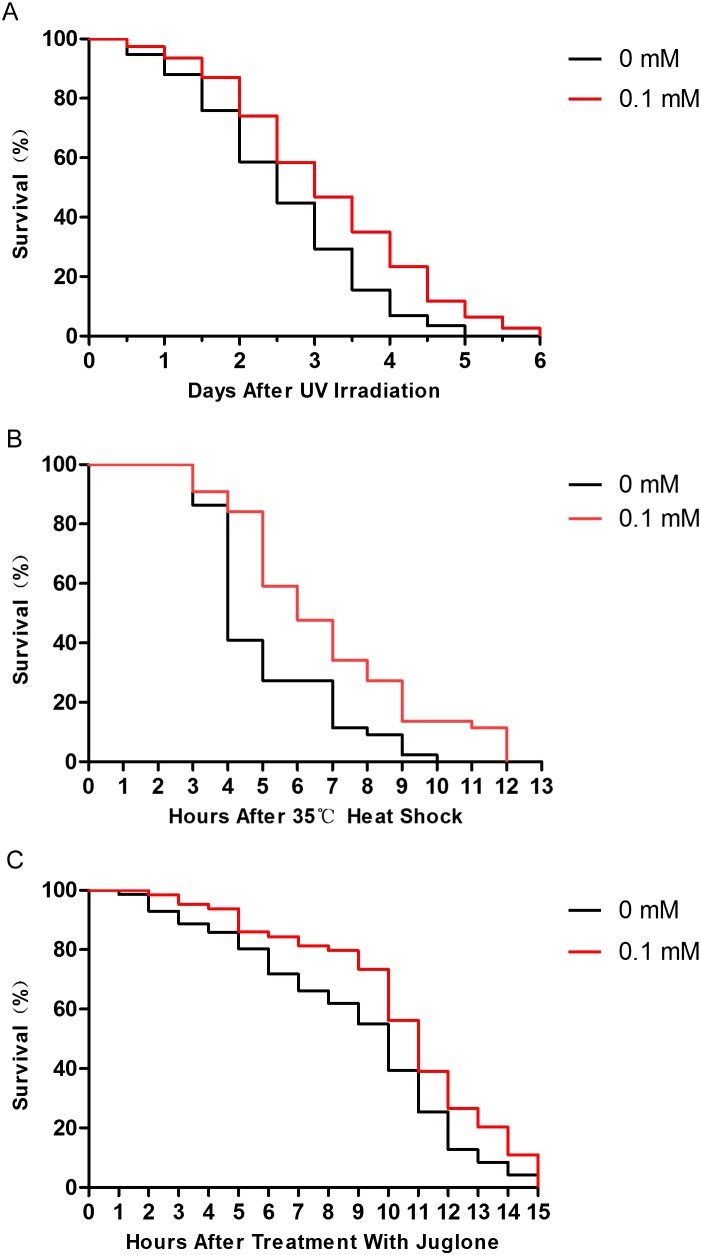
Didymin improved the survival of wild-type C. elegans nematodes exposed to various stressors.The adult nematodes were treated with 0.1 mM didymin or DMSO (vehicle control) for 48 h, followed by three types of stressors. Compared to control nematodes, didymin significantly raised the resistance of nematodes to (A) UV irradiation (n > 100, p < 0.01), (B) heat shock at 35 °C (n > 100, p < 0.001), and (C) juglone-induced oxidation (n > 100, p < 0.001).